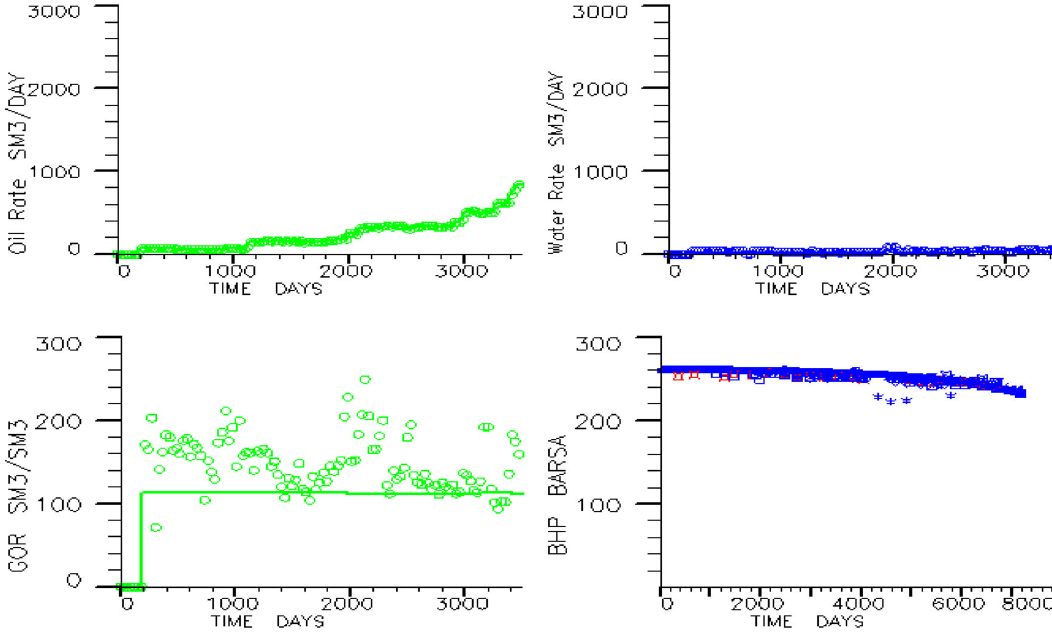
Fig. 7 History match results at field